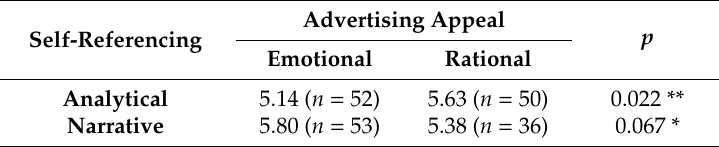
Table 3. Simple main e ff ect of